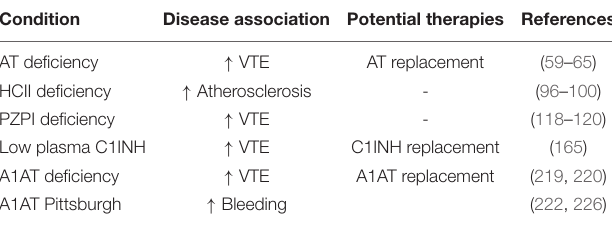
TABLE 2 | Associations between SERPIN abnormalities and atherothrombotic